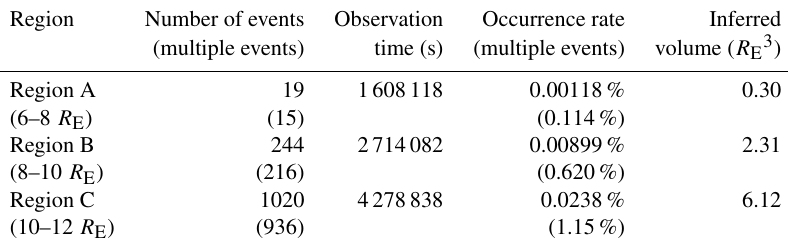
Table 1. Occurrence rate and inferred volume of the onset region ( R > 0 . 5).